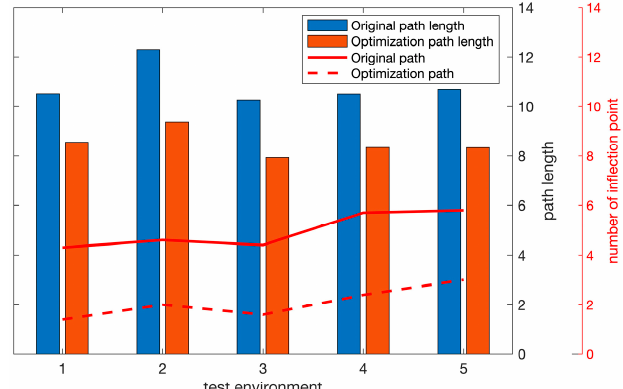
Figure 15. Path Optimization Algorithm Results.